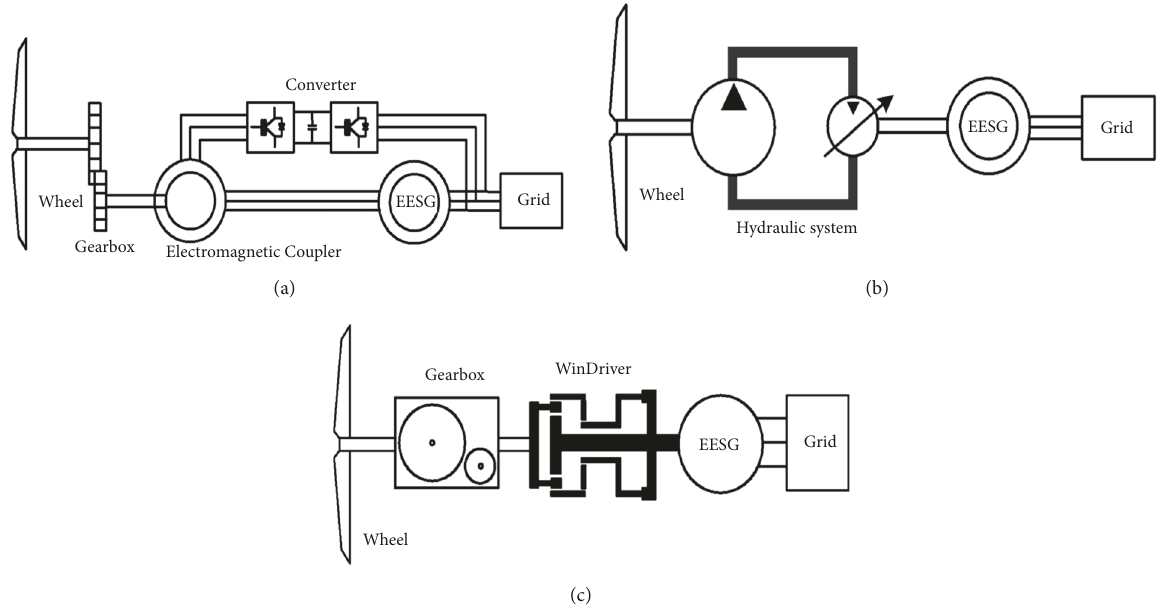
Figure 1: Schematic of front-end speed regulated wind turbines.